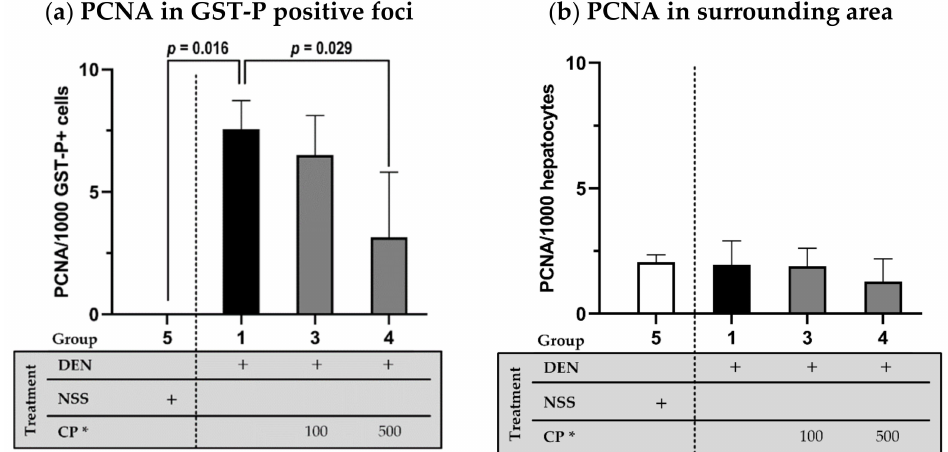
Figure 4. The effect of CP on PCNA expression in GST-P positive foci area ( a ) and surrounding area ( b ). DEN or NSS were initially administered at week 0 and 1. Then either DW (for groups 1 and 5) or CP were fed weekly starting from week 2 till the end of the experiment. Data displays non-normal distribution (Shapiro-Wilk and Levene’s test: p < 0.05) and was analyzed for statistical difference using non-parametric Mann–Whitney U test. * CP dosage unit; mg/kg